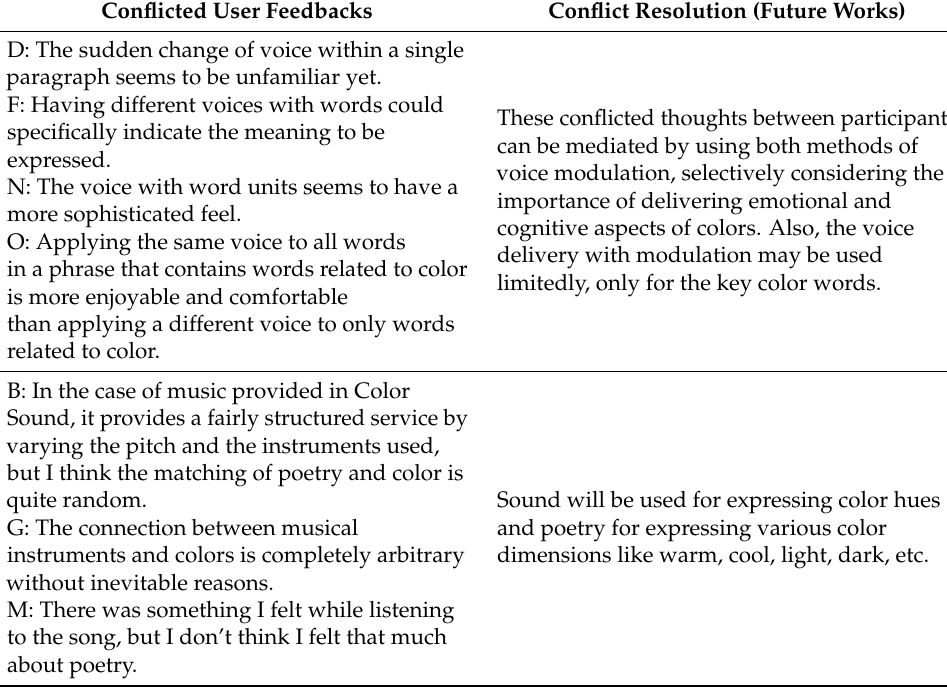
Table 12. Critical and conflicted user feedback and future